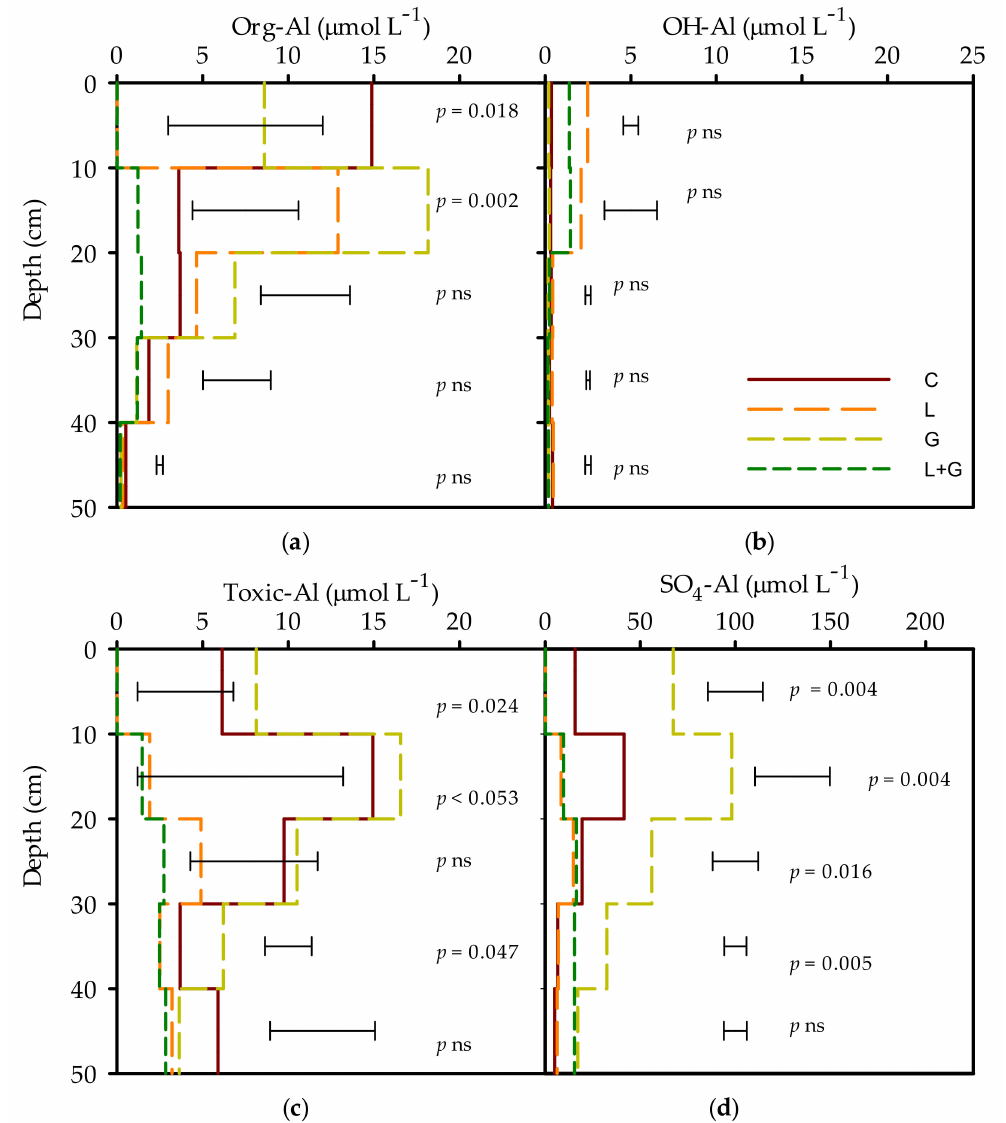
Figure 6. The LT effect on ( a ) Org-Al, ( b ) OH-Al, ( c ) Toxic-Al, and ( d ) SO 4 -Al ( µ mol L − 1 ) for the treatments C, L4, G2 and L4 + G2 application. Error bars represent the least significant difference. The abbreviation ns denotes not significant at p ≤ 0.05, n =